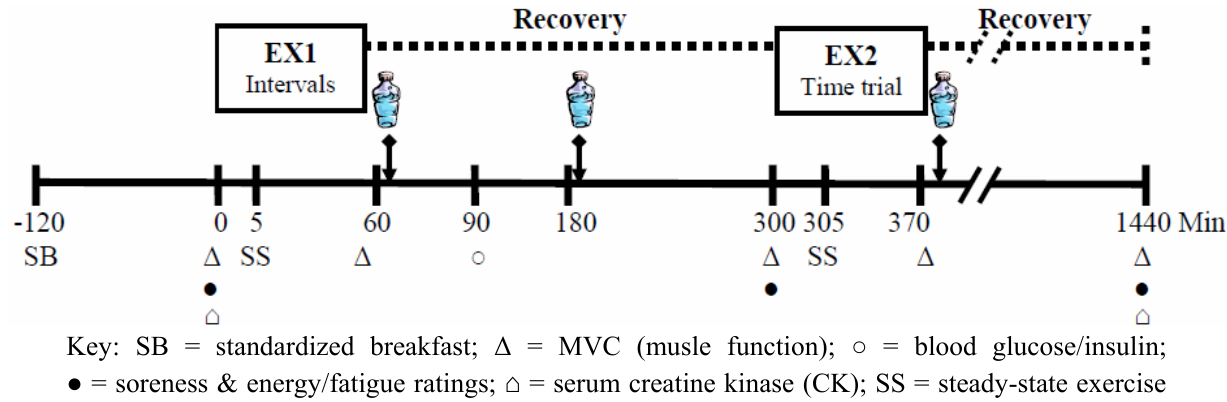
Figure 1. Schematic Representation of the Timeline for each